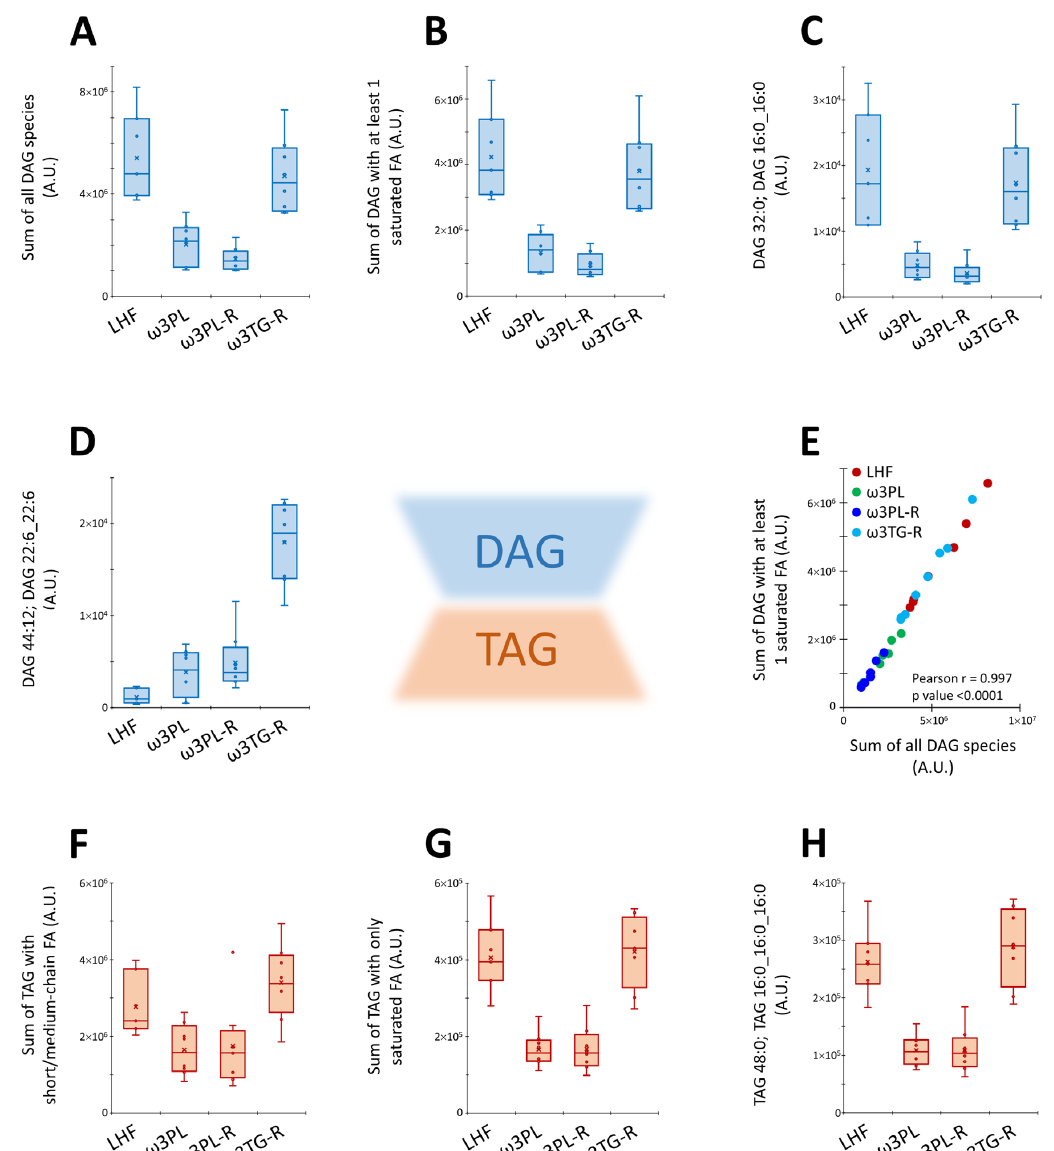
Figure 9. Box plots and correlation analysis for DAGs and TAGs lipid classes in the liver in response to dietary challenges: the sum of all DAG species ( A ; n = 37), the sum of DAGs with at least 1 SFA ( B ; n = 20), and representative species of DAGs containing either SFA (i.e., DAG 32:0; DAG 16:0_16:0; C ) or omega-3 PUFAs (i.e., DAG 44:12; DAG 22:6_22:6; D ). Correlation between the sum of all DAG species ( n = 37) and the sum of DAGs with at least 1 SFA ( n = 20; E ). The sum of TAG species with short/medium-chain FAs ( F ; n = 9), the sum of TAG species with only SFAs ( G ; n = 3), and a representative SFA-containing TAG species TAG 48:0; TAG 16:0_16:0_16:0 ( H ). Lipid intensities are in arbitrary units